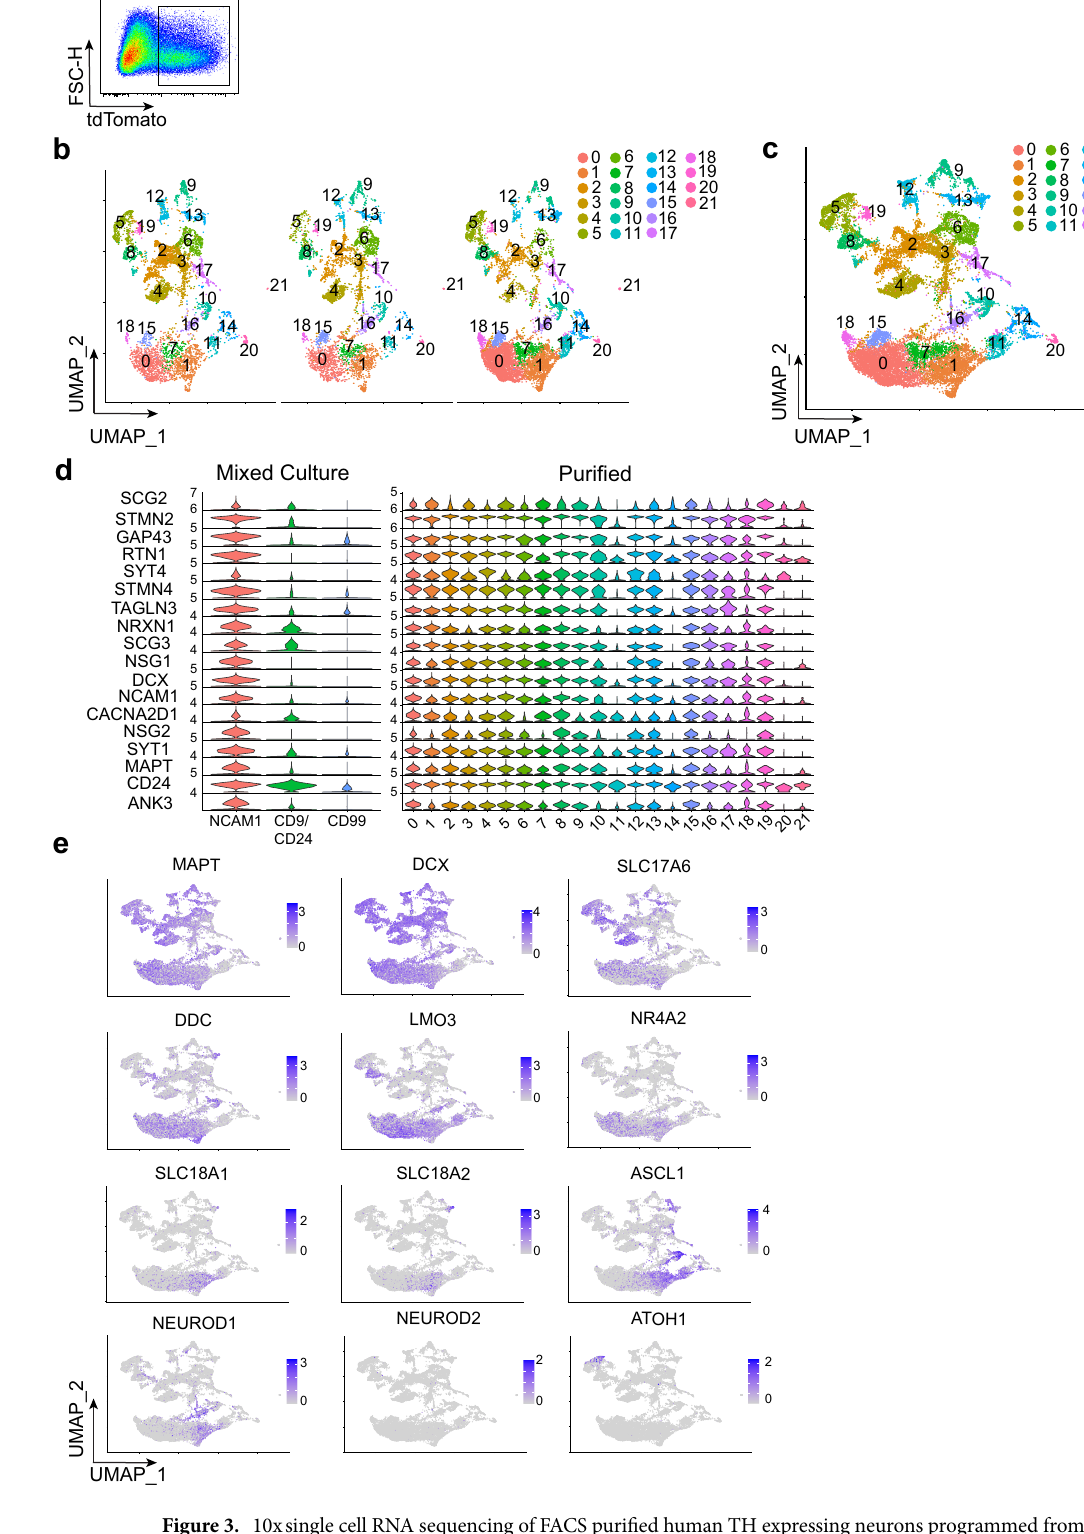
Figure 3. 10x single cell RNA sequencing of FACS purified human TH expressing neurons programmed from iPSCs. ( a ) FACS plot of live TH expressing cells from a Th-P2A-tdTomato iPSC line. ( b ) UMAP of integrated cell type clustering from FACS purification with cell types numbered ( n = 3 independent differentiations). ( c ) Merged UMAP of cell type clustering from ( b ). ( d ) Stacked violin plots of normalized RNA expression for neuronal markers comparing neural mixed culture cell classes to purified neuron cell type clusters. ( e ) Feature maps of normalized RNA expression plotted as UMAP for neuronal, glutamatergic, dopaminergic, and bHLH transcription factor